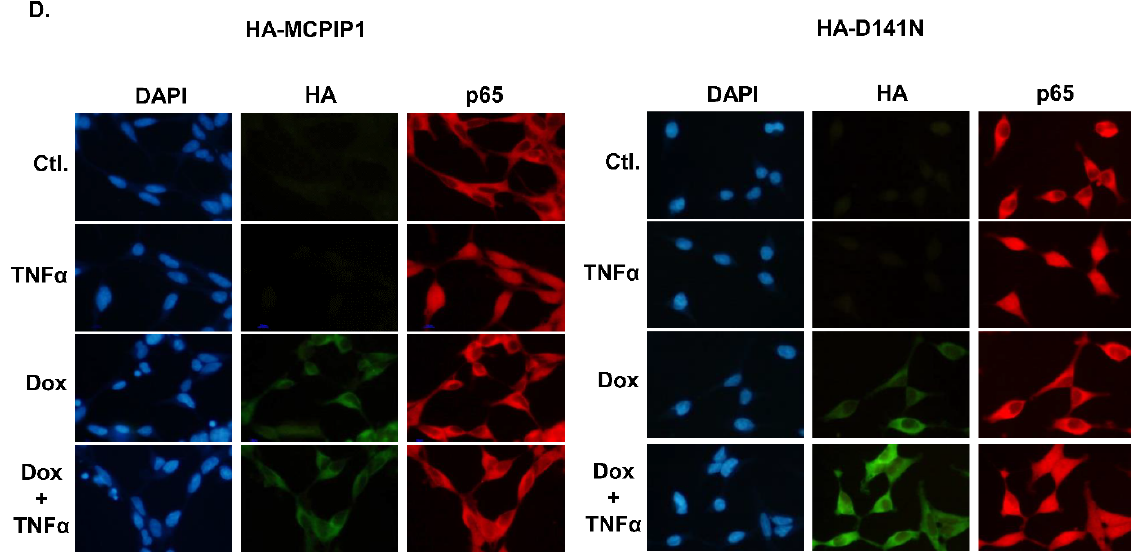
Figure 4. Overexpression of MCPIP1 suppressed NF- κ B activation in TNF- α -treated cells. T-REx-293 cells with ( A ) wild-type hemagglutinin (HA)-MCPIP1 or ( B ) the HA-MCPIP1-D141N mutant (HA-D141N) were pretreated without or with 1 μ g/mL of doxycycline (Dox) for 16 h, and then treated without or with 10 ng/mL TNF- α for 30~90 min. Total cell lysates were collected and protein expressions were determined by Western blotting. ( C , D ) T-REx-293 cells with wild-type HA-MCPIP1 or the HA-MCPIP1-D141N mutant (HA-D141N) were pretreated without or with 1 μ g/mL of Dox for 16 h, and then treated with 10 ng/mL TNF- α for ( C ) 15 or ( D ) 30 min. ( C ) Total cell lysates were collected, and I κ B kinase (IKK) activity was determined by an in vitro kinase activity assay. ( D ) Cells were fixed and IF staining was performed with NF- κ B p65 and HA antibodies, and DAPI was used as a counterstain for DNA.